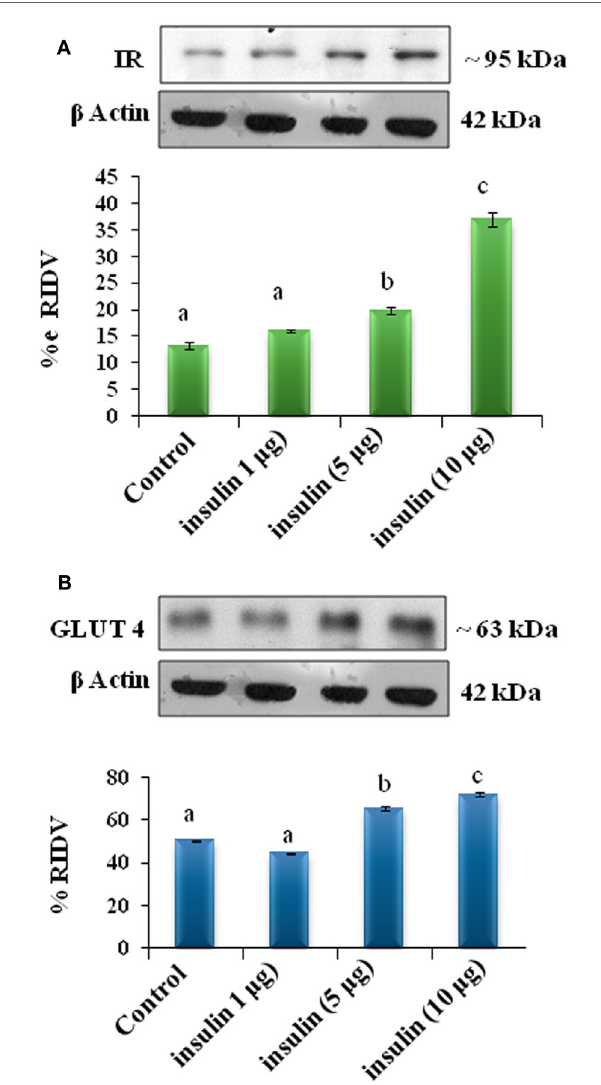
FigUre 5 | The in vitro treatment with different doses of insulin (1, 5, and 10 μ g/ml) on expression of insulin receptor and glUT4 proteins in the adipose tissue. The treatment of insulin showed dose-dependent significant (b, c and d, p < 0.05) increase in expression of IR (a) and (b and c, p < 0.05) GLUT4 (B) proteins in the adipose tissue as compared with the control (a, p < 0.05).